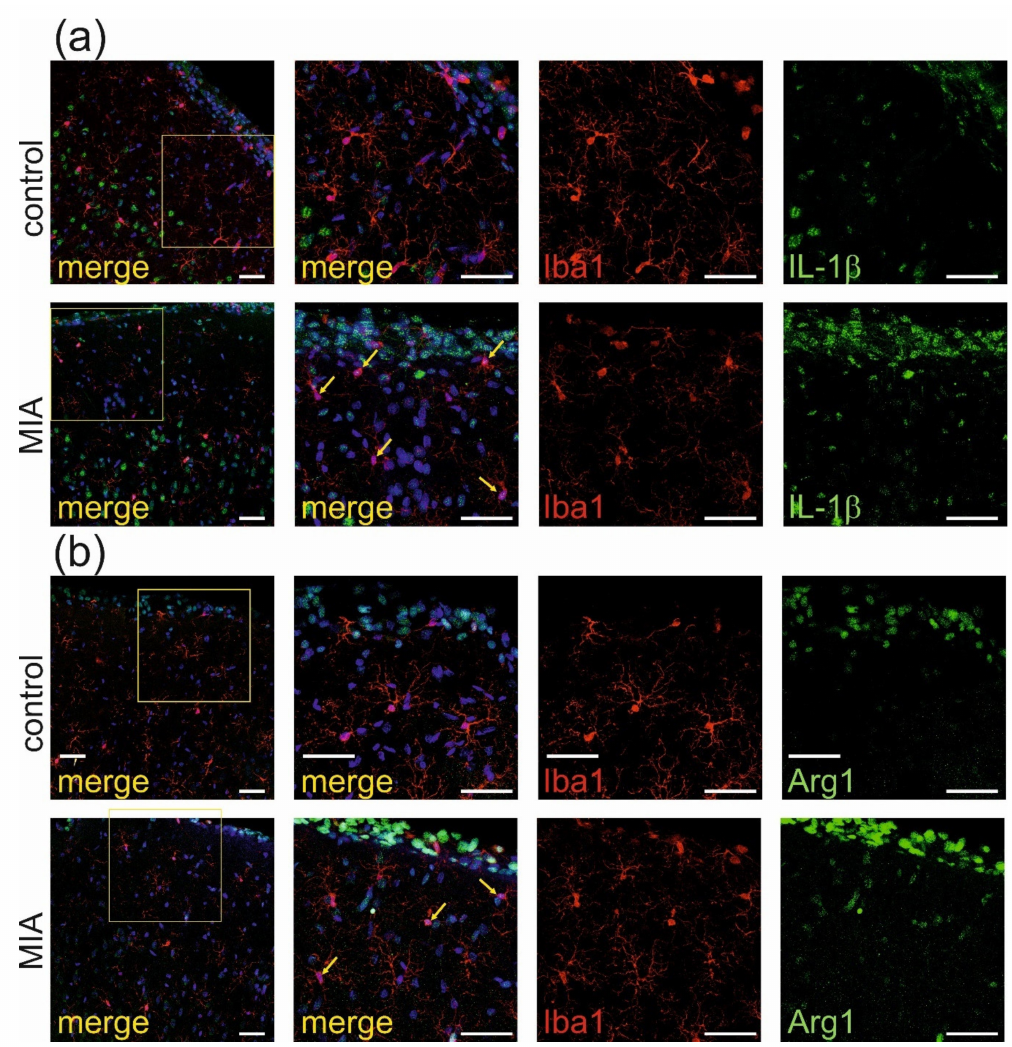
Figure 6. MIA induces activation of microglia a in brain cortex of adolescent male rats. Immunohistochemical analysis of somatosensory cortex illustrating microglia cells (Iba-1—red) in control and MIA-exposed groups. Co-expression of activation markers, ( a ) IL-1 β (green) and ( b ) arginase-1 (green), with Iba1-positive cells has been observed. The nuclei were counterstained with DAPI (blue). Scale bar = 50 µ m. Yellow arrows indicate the cells which display the most evident